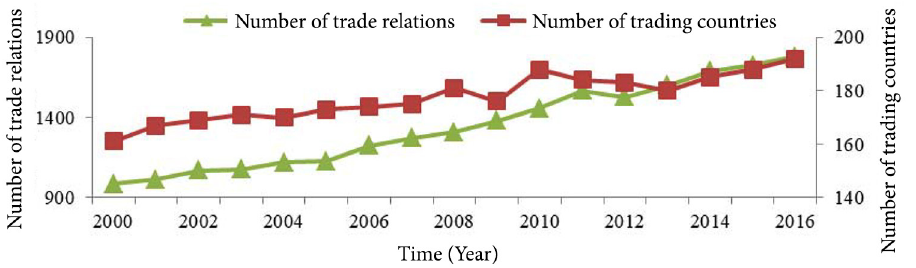
Figure 5. Evolution of the number of trade countries and relations